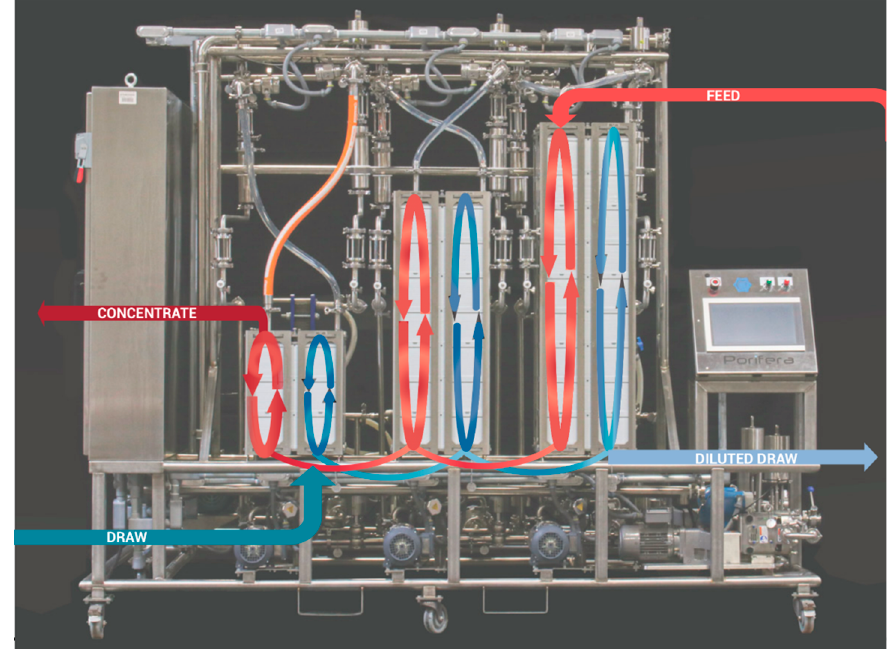
Figure 1. Schematic diagram of industrial-scale forward osmosis (FO) system used in this